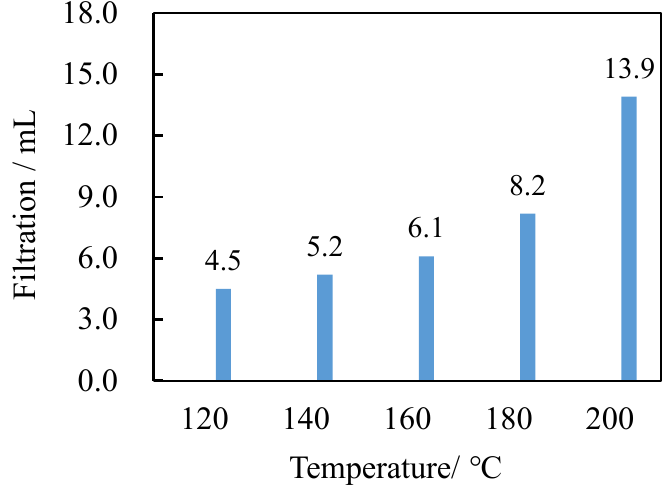
Figure 6. Experimental results of temperature resistance evaluation of modified starch.